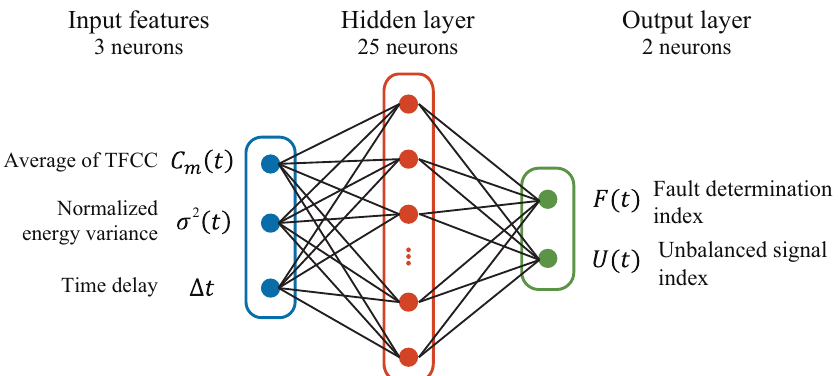
Figure 2. Structure of the neural network used for fault detection and